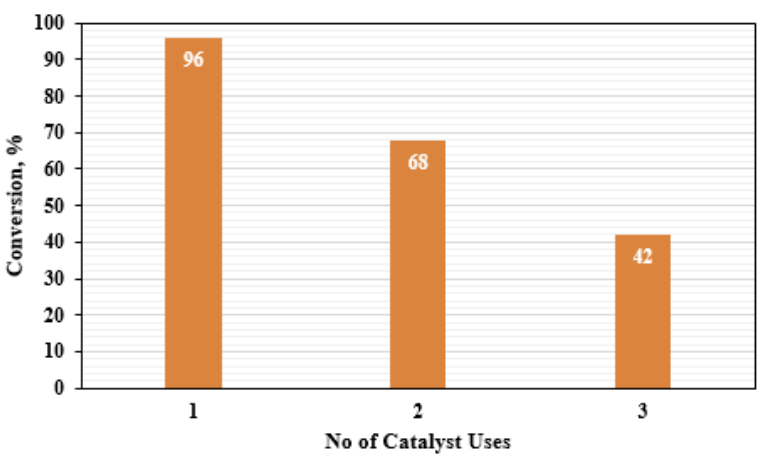
Figure 20. Reusability test results .